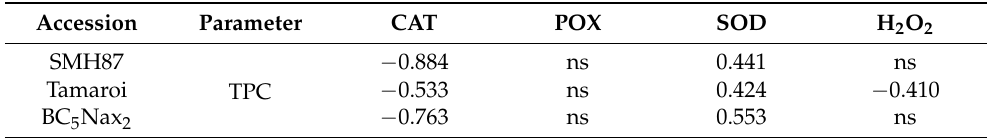
Table 4. Pearson coefficients of linear correlation ( p < 0.05) between TPC and antioxidant enzyme activity and H 2 O 2 content in the leaves of three durum wheat